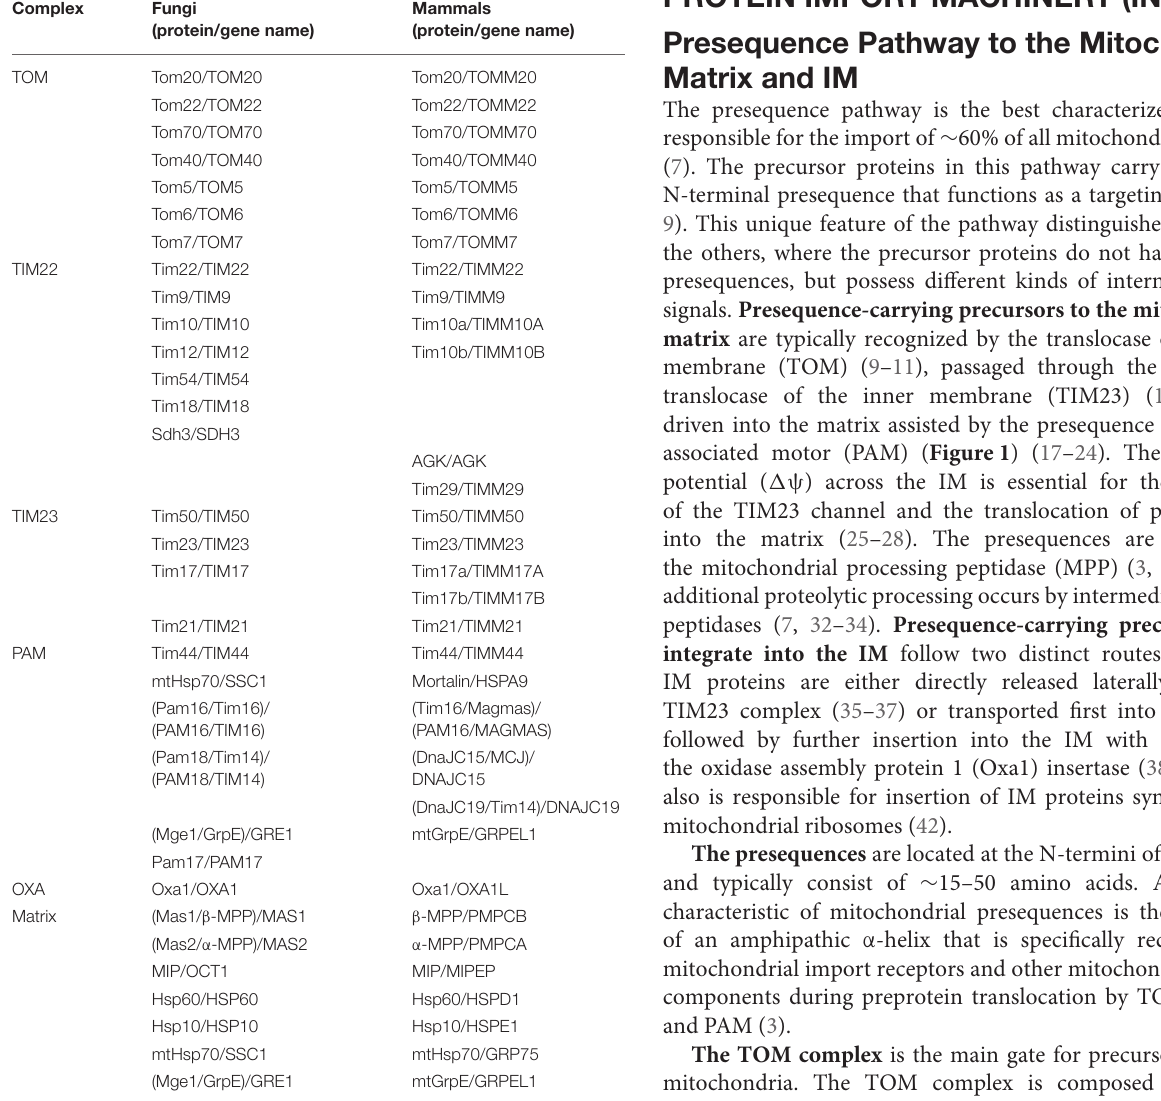
TABLE 1 | Components of mitochondrial import machinery in fungi and mammals. Complex Fungi (protein/gene name)